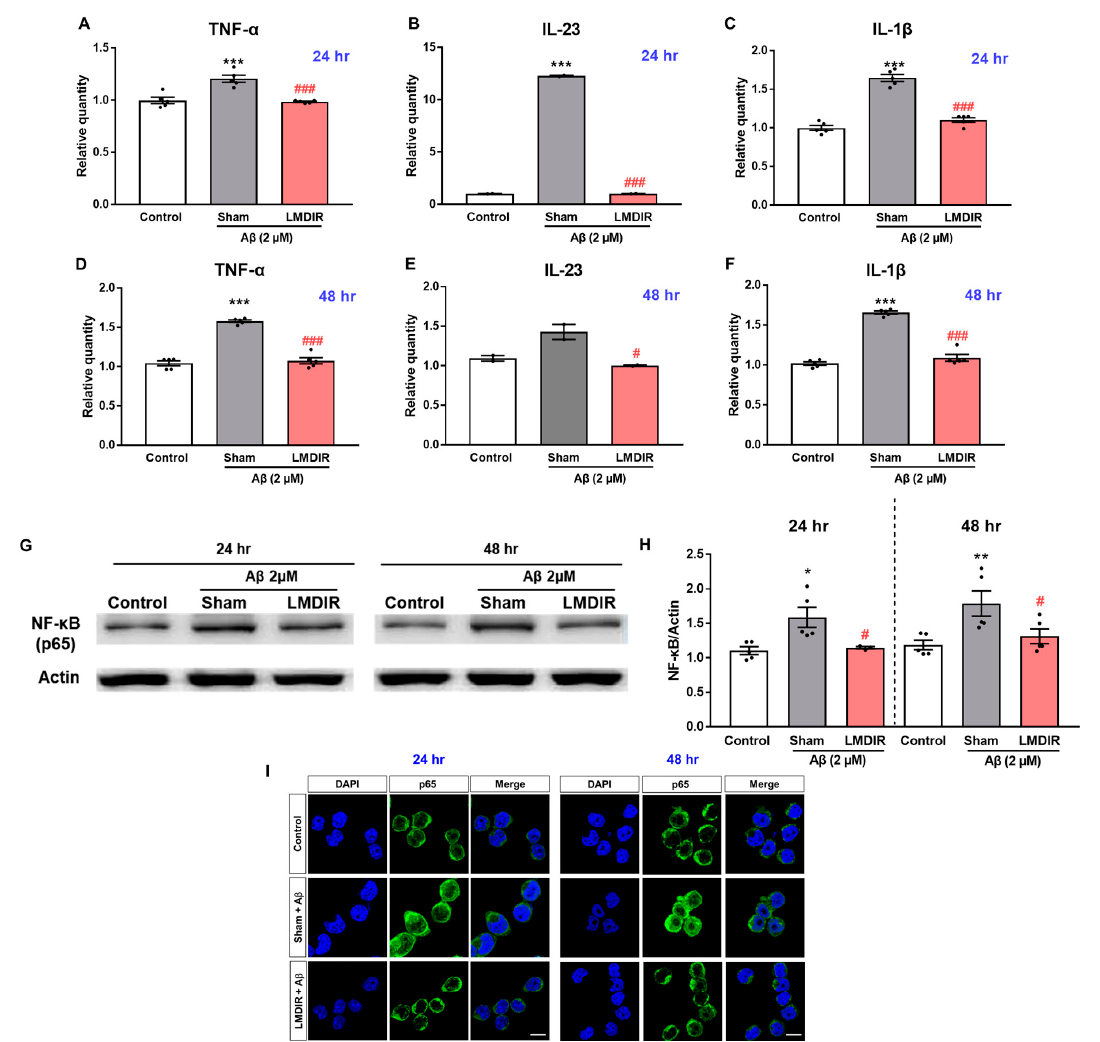
Figure 6. Anti-neuroinflammatory e ff ect of LMDIR against A β toxicity in cultured microglia cells. BV-2 cells were exposed to LMDIR (1 Gy), and then incubated with 2 µ M A β for 24 or 48 h. ( A – F ) The mRNA levels of pro-inflammatory cytokines in BV-2 cells 24 and 48 h after treatment with A β or / and LMDIR were measured using quantitative real-time PCR. LMDIR exposure ameliorated the A β -induced production of pro-inflammatory cytokines in BV-2 cells. (G,H) Representative Western blots. For NF- κ B detection, Western blotting was performed using p65 and actin antibodies in the lysate of BV-2 cells. p65 were normalized to actin. ( I ) Cellular localization and expression of NF- κ B p65 were analyzed by immunofluorescence staining. After A β treatment, the translocation of NF- κ B p65 into the nucleus was remarkably increased in sham-treated microglia cells compared to control groups. However, the A β -induced translocation was inhibited in LMDIR- and A β -treated microglia cells compared to sham- and A β -treated microglia cells. Scale bar = 10 μ m. Data are presented as mean ± SEM. # p < 0.05 and ### p < 0.001: control versus sham-exposed BV-2 cells. * p < 0.05, ** p < 0.01 and *** p < 0.001: sham-exposed BV-2 cells versus LMDIR-exposed BV-2 cells. LMDIR, low–moderate dose ionizing radiation; A β , amyloid- β , NF- κ B, nuclear factor-kappa B; TNF- α , tumor necrosis factor-alpha; IL, interleukin.